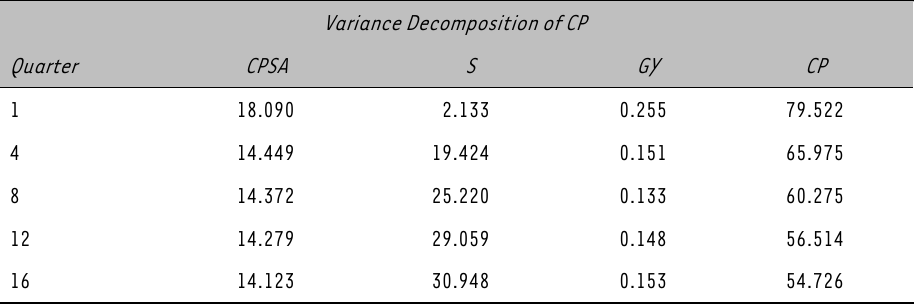
Variance decomposition for the exchange rate pass-through Variance Decomposition of